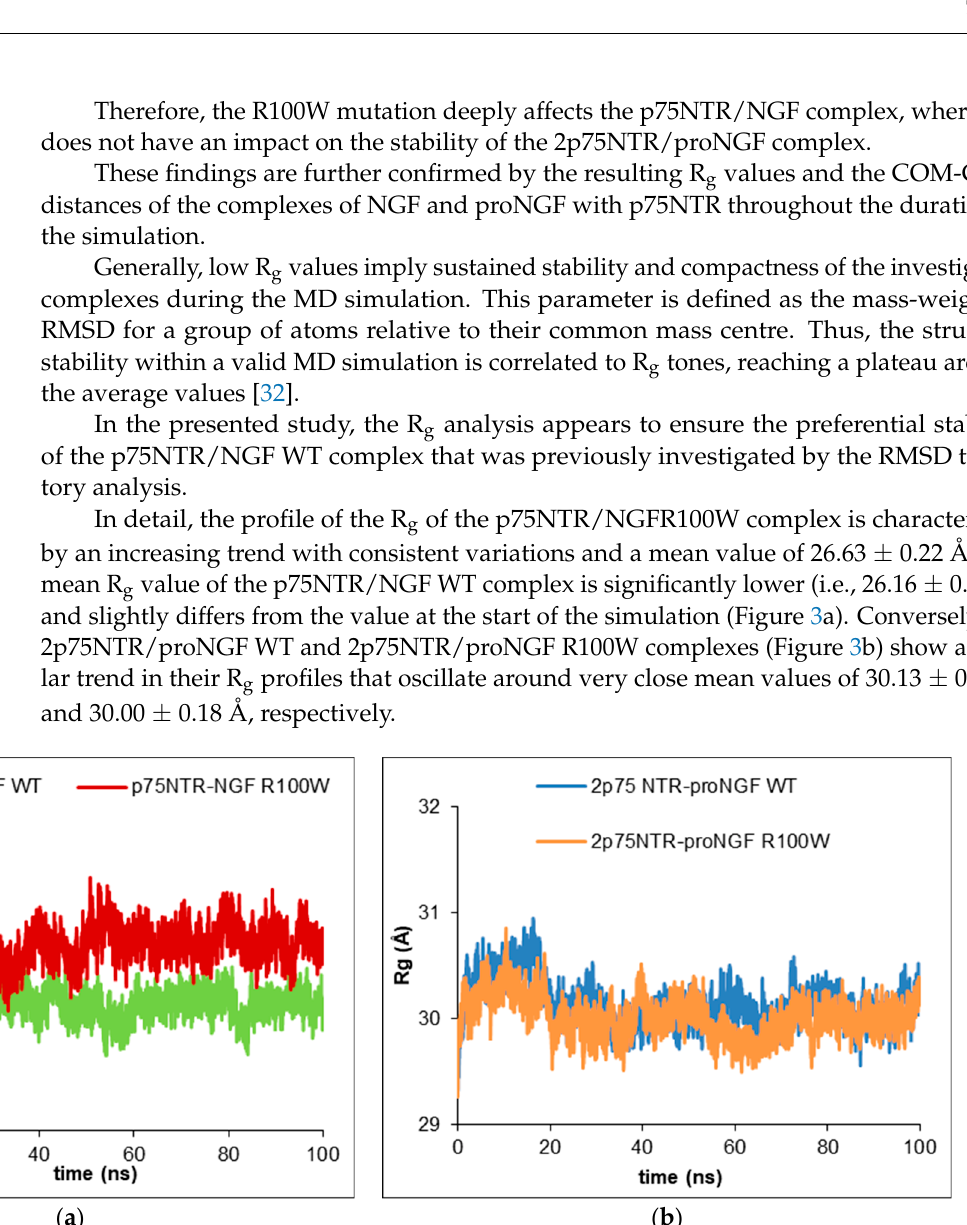
( c ) Figure 4. Plots of the centres of mass distance of the complexes: ( a ) p75NTR/NGF, ( b ) p75NTR_X/proNGF, and ( c ) p75NTR_Y/proNGF.